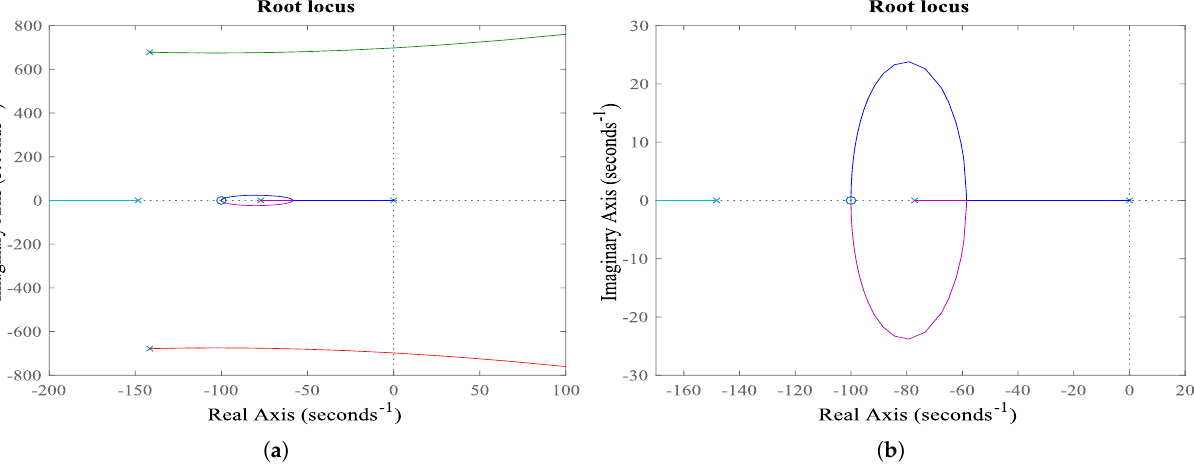
Figure 4. ( a ) Root locus plot for the outer position loop as a function of the gain K p ; ( b ) zoomed view of the root locus. The system is stable as the gain K p is increased up to the upper boundary value given by (39).